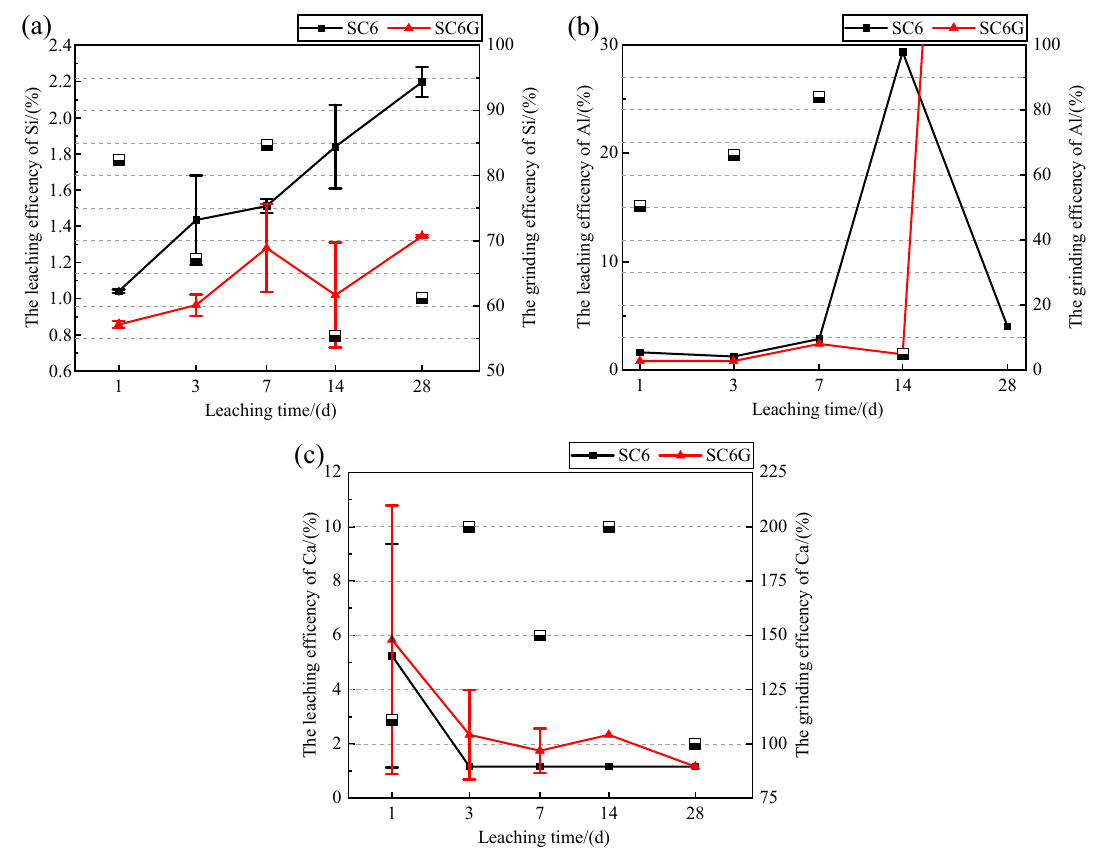
Figure 4. The grinding e ffi ciency between SC6 and SC6G. ( a ) The ion leaching e ffi ciency of Si, ( b ) the ion leaching e ffi ciency of Al, and ( c ) the ion leaching e ffi ciency of Ca. (The plots in the fi gure correspond to the grinding e ffi ciency on the right axis).